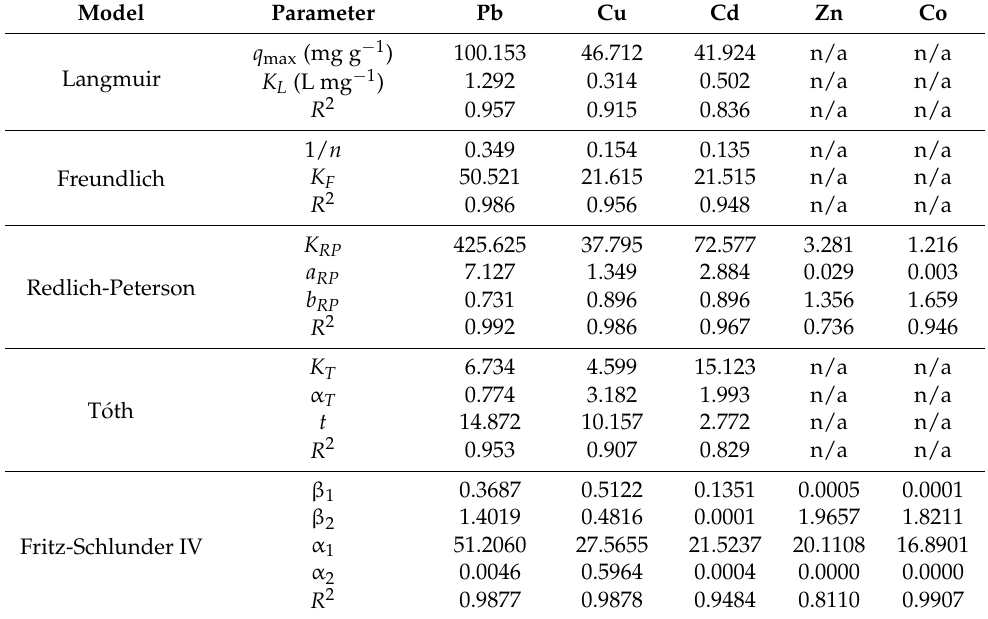
Table 4. ZVK-FAU nonlinear adsorption isotherms (C 0 = 100 to 500 mg L -1 at 90 min and 5 g L -1 adsorbent loading).